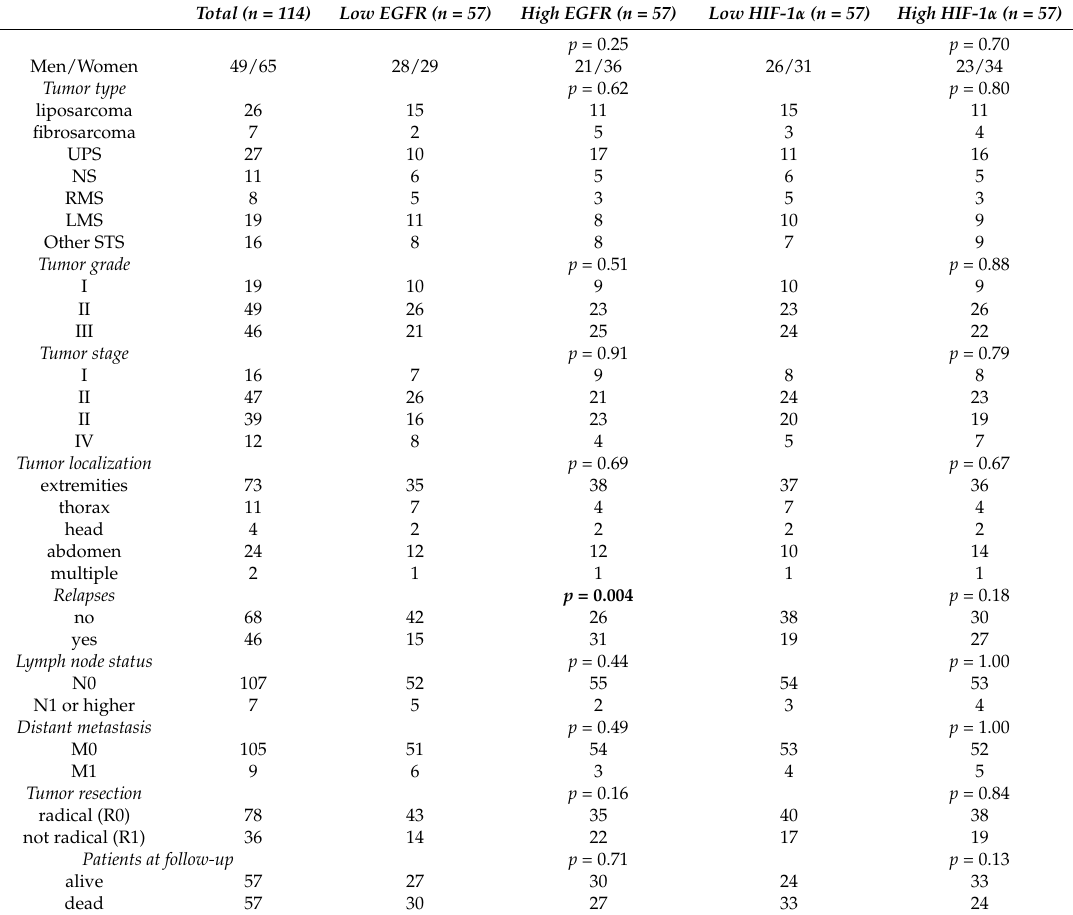
Table 1. Histopathological, clinical, and mRNA expression